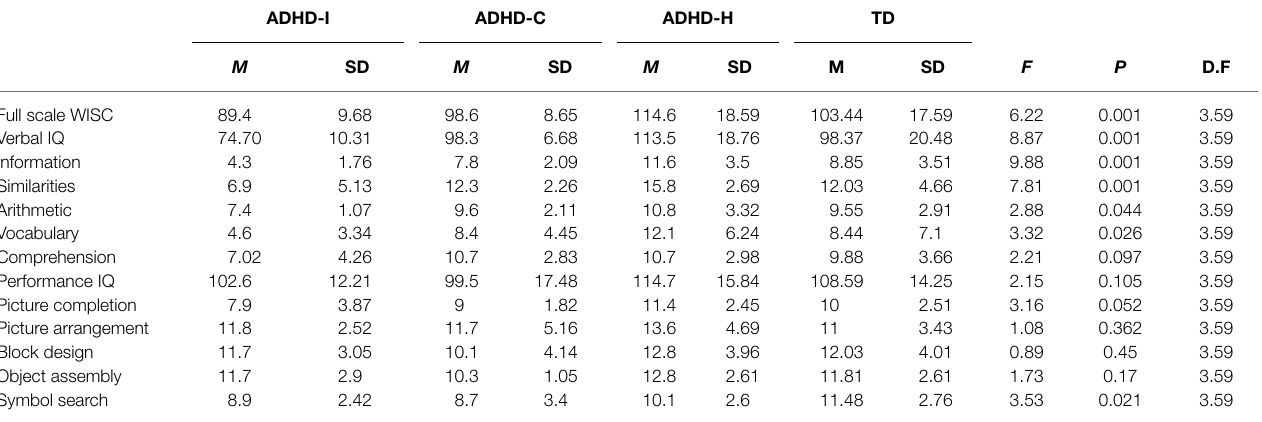
TABLE 2 | Means, Standard deviations, and statistical test for each group and for each WISC subtest.